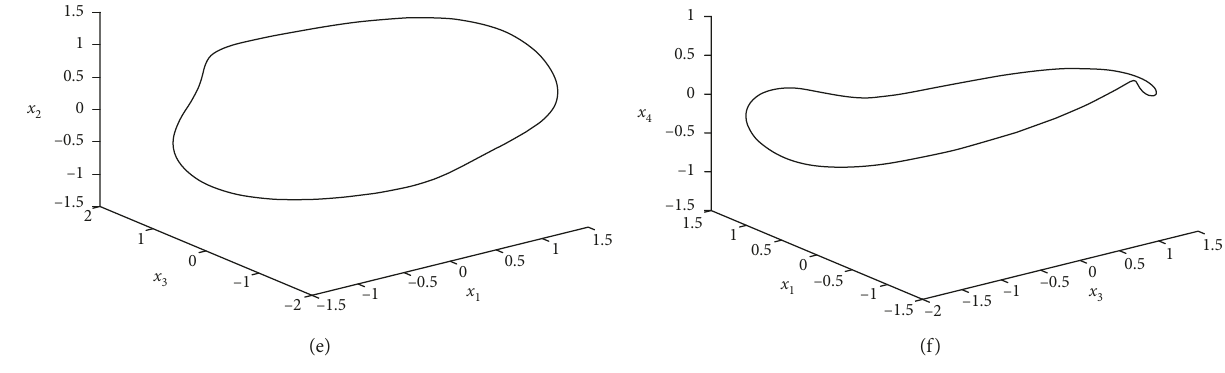
Figure 19: Periodic-1 motion occurs when b